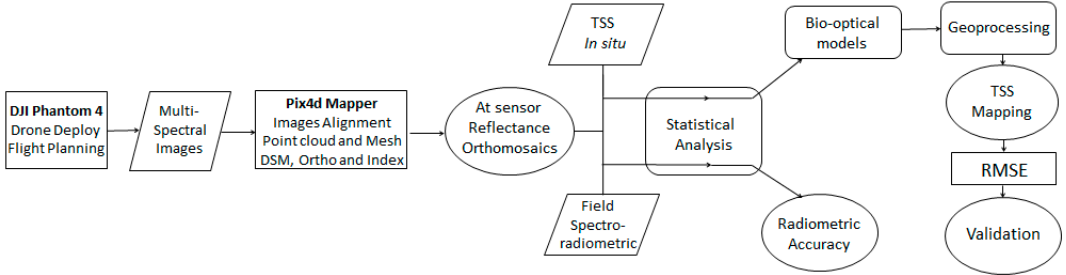
Figure 1. Flowchart of methodological procedures for TSS mapping, validation, and radiometric accuracy analysis of the unmanned multispectral platform.